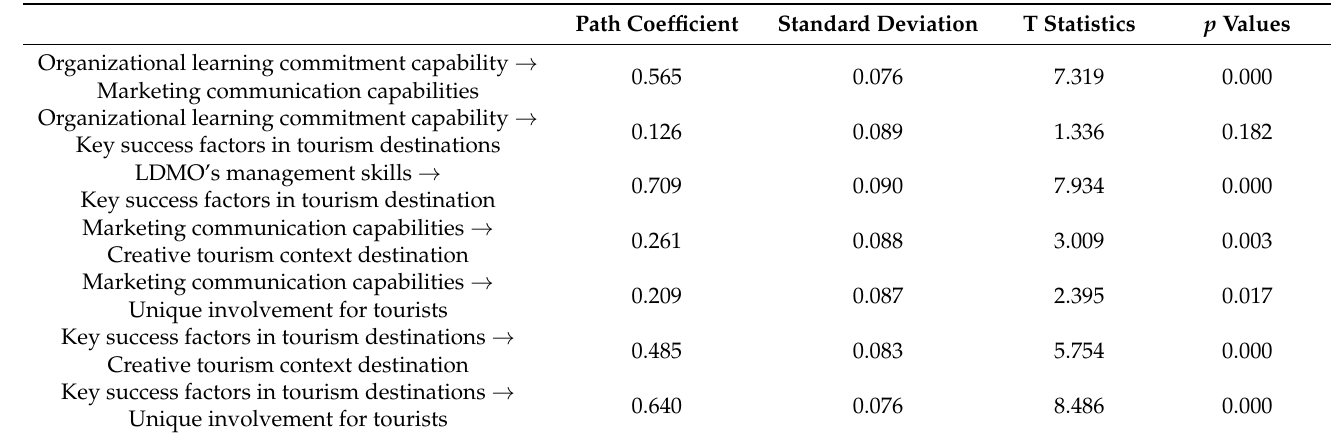
Table 2. Structural model assessment.